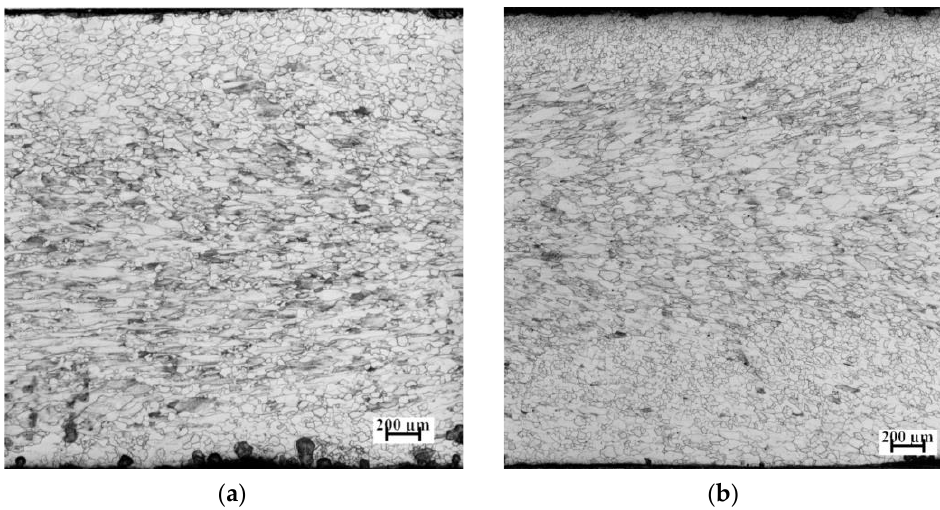
Figure 3. Micrographs in transverse section of hot-rolled sheets 1# ( a ) containing 1%Si and 2# ( b ) containing 0.72%Si.